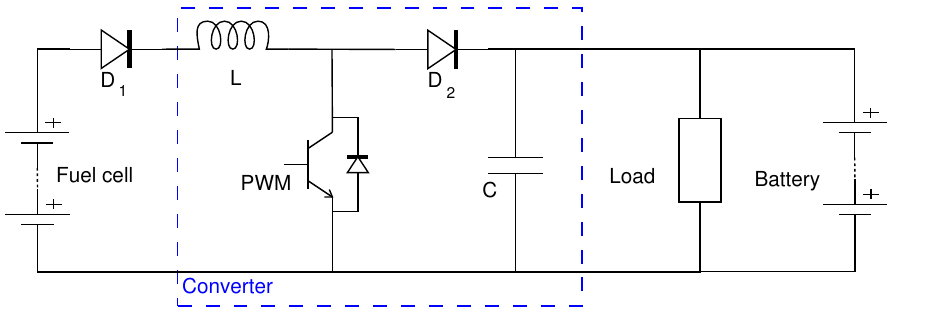
Figure 6. Semi-active configuration schematic.